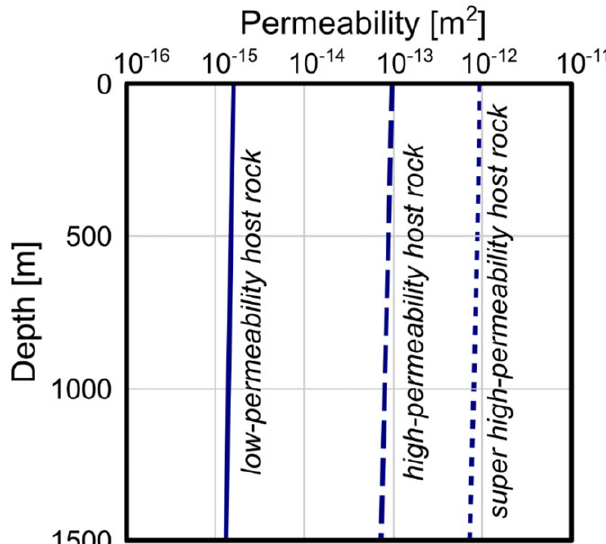
Figure 8: Permeability as a function of depth for the three model host-rocks, one with high, one with low, and one with super-high permeability. The functions are derived from fitting exponential functions to the empirical values derived by Eg- gertsson et al. [2020]. See also Appendix D, Figure D3, D4, D5, D6, and D7